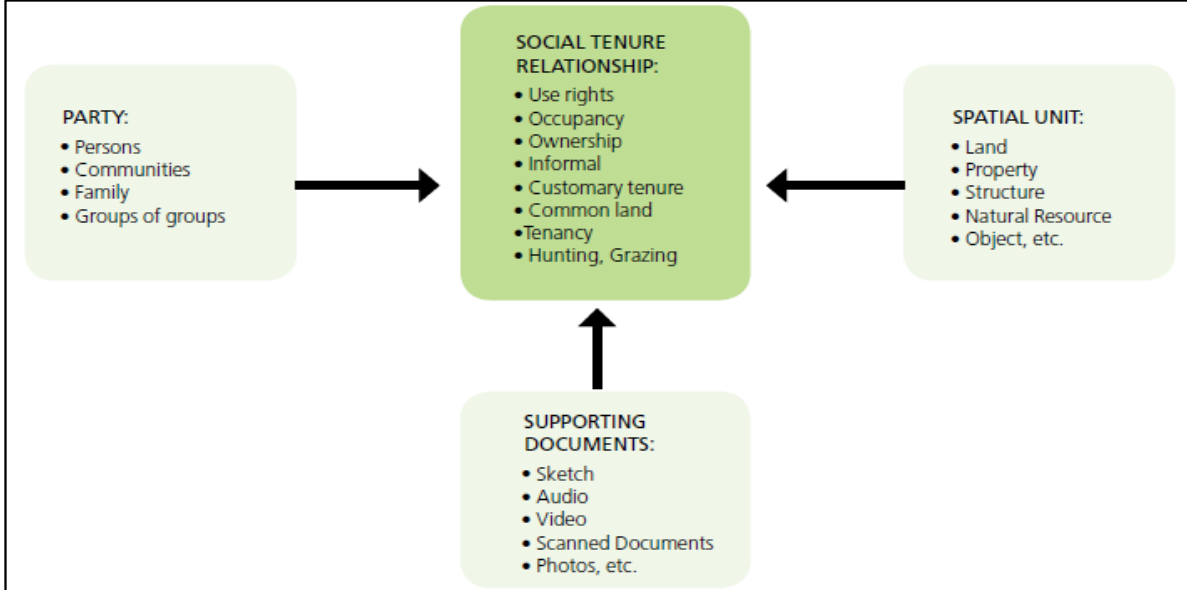
Figure 1. The conceptual model for the Social Tenure Domain Model (STDM).